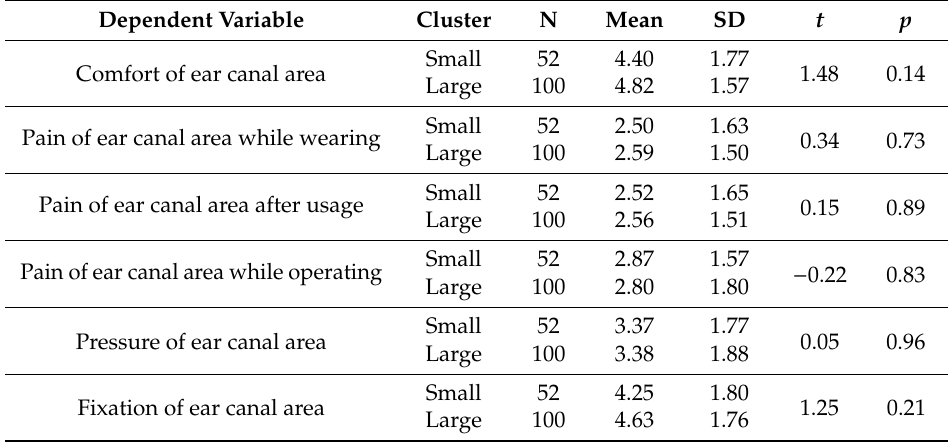
Table 11. Results of independent sample t -test for wearing comfort di ff erence according to ear canal width clusters.